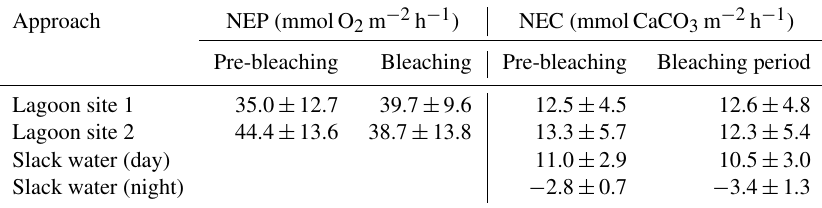
Table 4. Mean ± SD values for daytime net ecosystem production (NEP; mmolO 2 m − 2 h − 1 ) and net ecosystem calcification (NEC; mmolCaCO 3 m − 2 h − 1 ) for lagoon site 1 and lagoon site 2, where the Eulerian approach was used ( n = 12). NEC for the slack-water approach included for daytime ( n = 11) and nighttime ( n = 3) estimates. Data are separated by the pre-bleaching period (22 January– the slack-water approach given the large source of error in air–sea oxygen